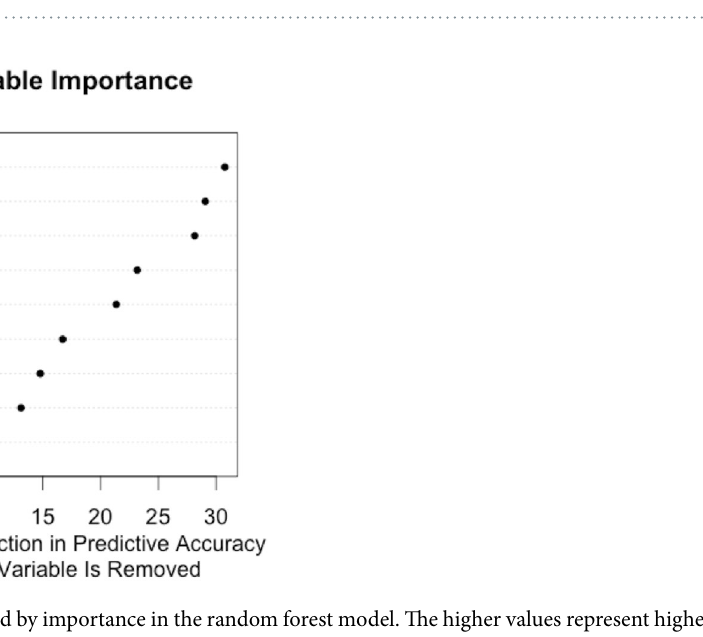
Figure 1. Actual reservoir levels compared to ( a ) the fitted values and ( b ) the predicted values. A 45-degree line has been plotted for reference.